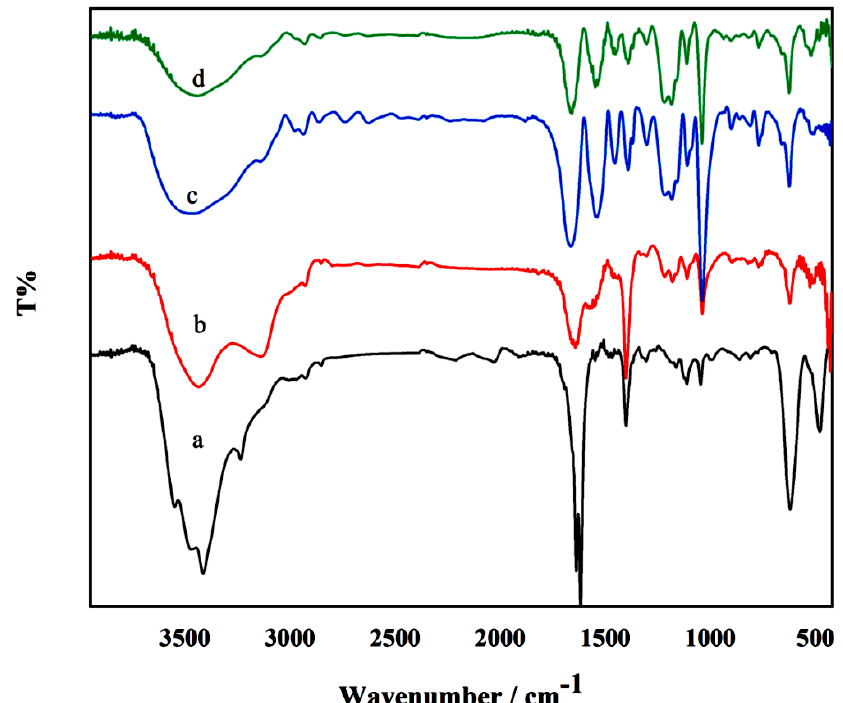
Fig. 8. FT-IR spectra of a) p(AMPS-Na + -VIm) hydrogel, b) p(AMPS-Na + -VIm)/Rh B (pH=2, 0.2 g), c) p(AMPS-Na + -VIm)/Rh B (pH=3, 0.2 g), d) p(AMPS-Na + -VIm)/Rh B (pH=3, 0.1 g),